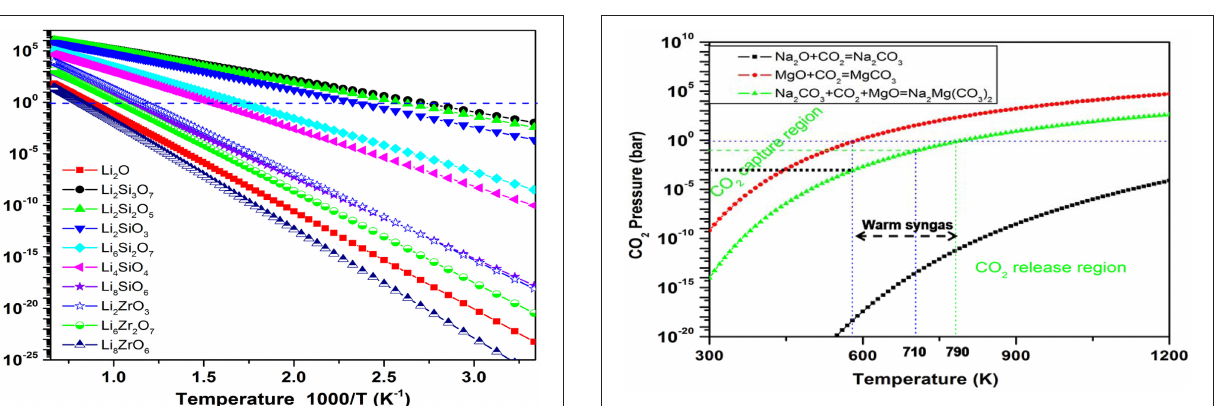
FIGURE 2 | Plots of the calculated free energy vs. CO 2 pressures and temperatures for the CO 2 capture reaction by Li 2 O + SiO 2 or Li 2 O + ZrO 2 mixtures. Y-axis plotted in logarithm scale. The line shows 1 G(T, P) = 0. For each reaction, above its 1 G(T, P) = 0 curve, its 1 G < 0, which means the solids absorb CO 2 and the reaction goes forward, whereas below the 1 G(T, P) = 0 curve, its 1 G > 0, which means the CO 2 starts to release and the reaction goes backward to regenerate the sorbents.